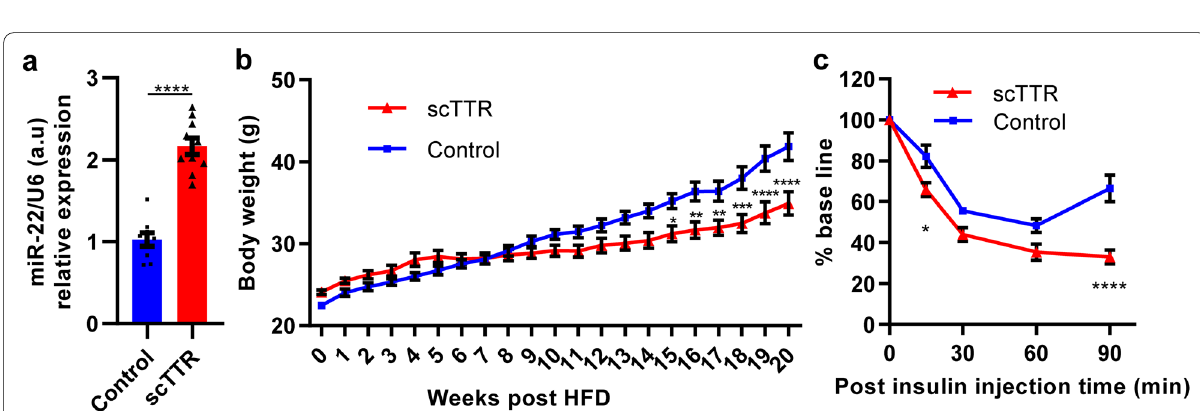
Fig. 6 Effect of hepatic miR-22 overexpression on bodyweight and insulin sensitivity in HFD mice. a miR-22 expression levels in the mouse livers 37 weeks post scTTR or SCEB injection and HFD treatment for 35 weeks ( n or SCEB vectors ( n 10 for each group). c The insulin tolerance test (ITT) of two groups of mice treated with scTTR or SCEB vectors ( n = group). All data were reported as